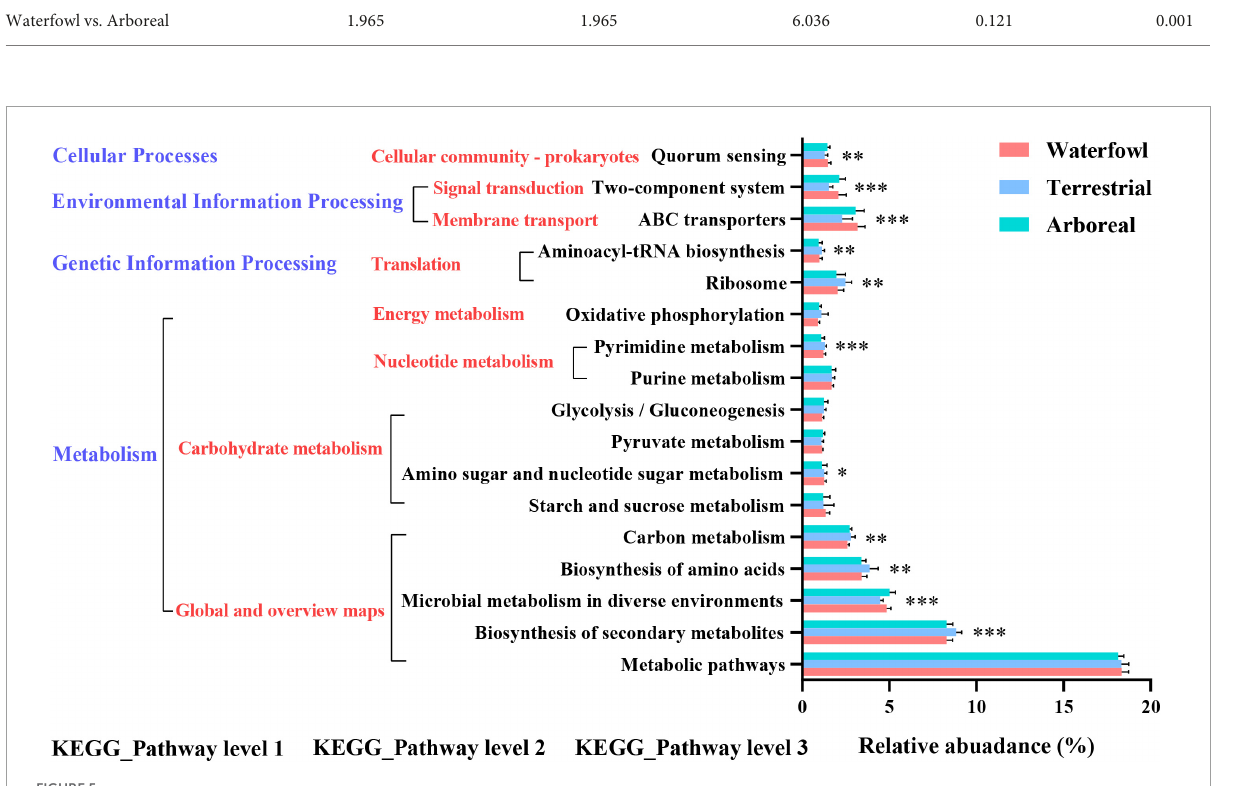
FIGURE5 Functional predictions for intestinal microflora with significantly different KEGG pathways ( P < 0.05) for the different ecological types of birds. KEGG pathways at Level 1, Level 2, and Level 3 are represented. (*0.01 < P < 0.05, **0.001 < P < 0.01, *** P <